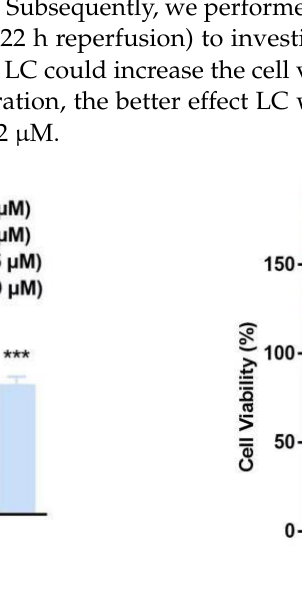
Figure 1. LC attenuated OGD/R-induced neuronal injury in vitro. ( a ) The viability of the SH-SY5Y measured by MTT. ( b ) The viability of the SH-SY5Y with OGD/R treatment measured by MTT. Data are expressed as mean ± SD ( n = 3). *** p < 0.001, ** p < 0.01 vs. Control group in ( a ); *** p < 0.001, ** p < 0.01 vs. OGD/R group, and ### p < 0.001 vs. Control group in ( b